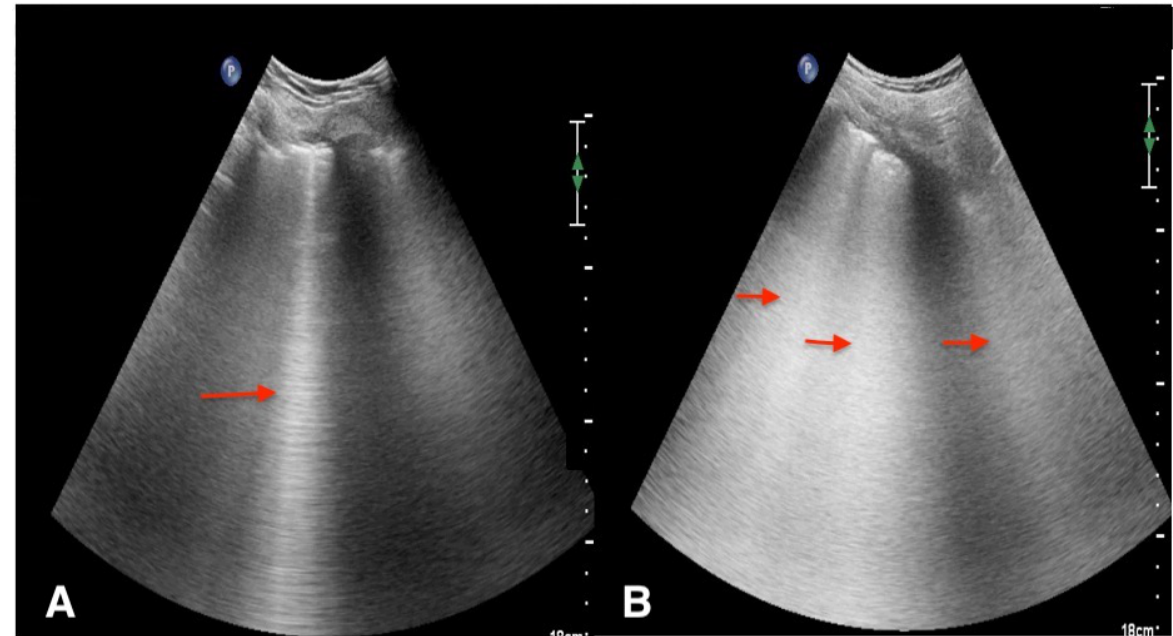
Figure 11. Interstitial syndrome with B-pattern in a patient with COVID-19 pneumonia. ( A ). One isolated B-line (red arrow) visualized on the upper areas bilaterally (longitudinal view, convex probe). ( B ). In the same patient, multiple coalescent B-lines are visualized in the lower area bilaterally (red arrows) arising from the pleural line and spreading up to the edge of the screen, representing interstitial involvement “B-pattern” (longitudinal view, convex probe). This corresponds to severe impairment in lung aeration resulting from partial filling of alveolar spaces by pulmonary edema.